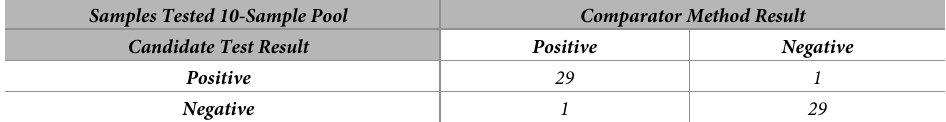
(samples collected on symptomatic patients). Performance of the UCSC Multiplex SARS-CoV-2 Assay on 10-sample pools against the Pangea comparator: